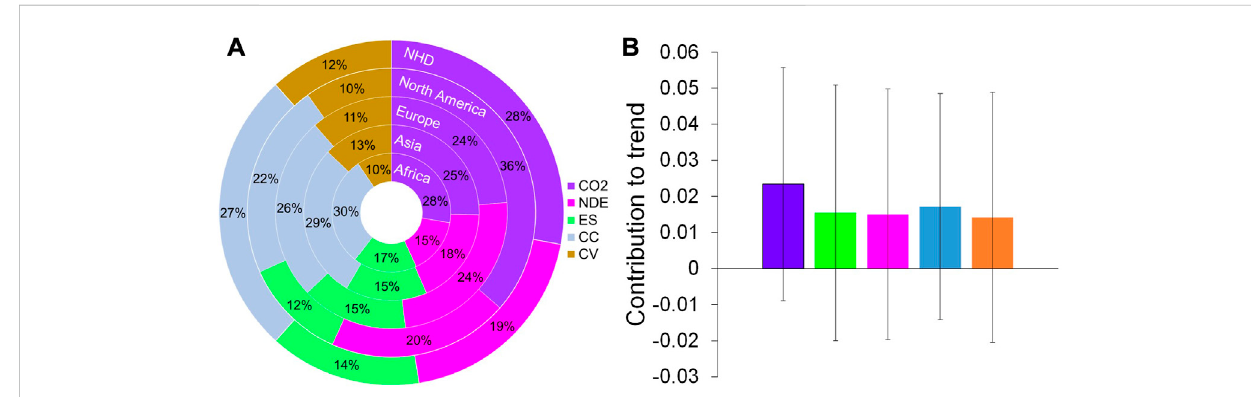
FIGURE 4 Climate and vegetation contributions to the enhanced response in the Northern Hemisphere drylands (NHD). (A) The proportional contribution of the control factors based on the Lindeman-Merenda-Gold method. (B) The contribution to the total trend for the fi ve major control factors. Abbreviations: CO 2 , NDE, ES, CC, and CV are the CO 2 concentration, nitrogen deposition, ecosystem structure, climate change, and climate vacillation, respectively.